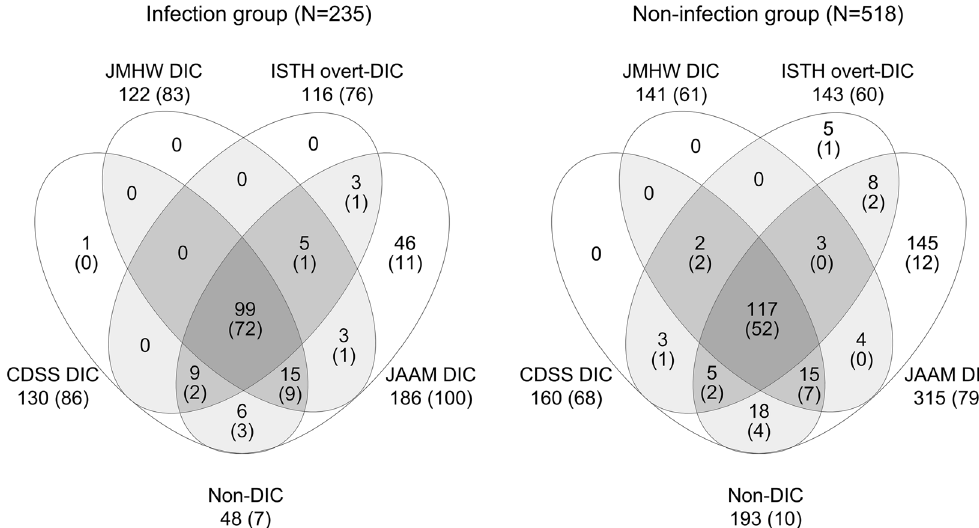
Figure 1. Relationships of the patients with disseminated intravascular coagulation (DIC) diagnosed by the four criteria. Left, comparisons in infection group; right, comparisons in non-infection group. CDSS, Chinese DIC Scoring System; JMHW, Japanese Ministry of Health and Welfare; ISTH, International Society on Thrombosis and Hemostasis; JAAM, Japanese Association for Acute Medicine; non-DIC, patients who didn’t meet the four criteria simultaneously. Numbers in parentheses are of nonsurvivors.